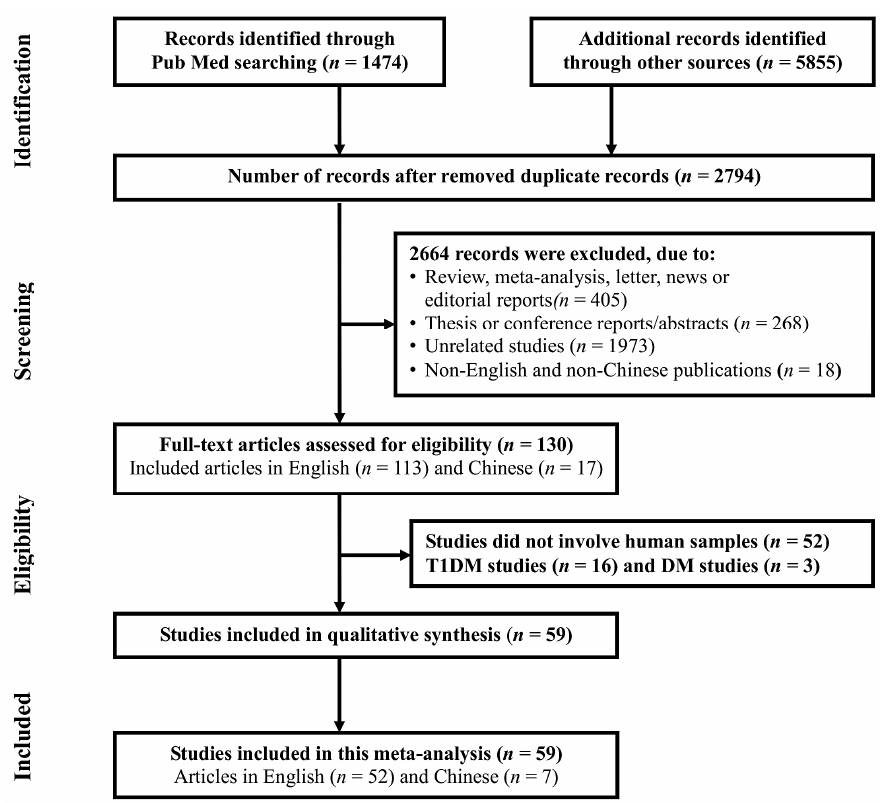
Figure 1. The flow chart of the data selection and identification process.